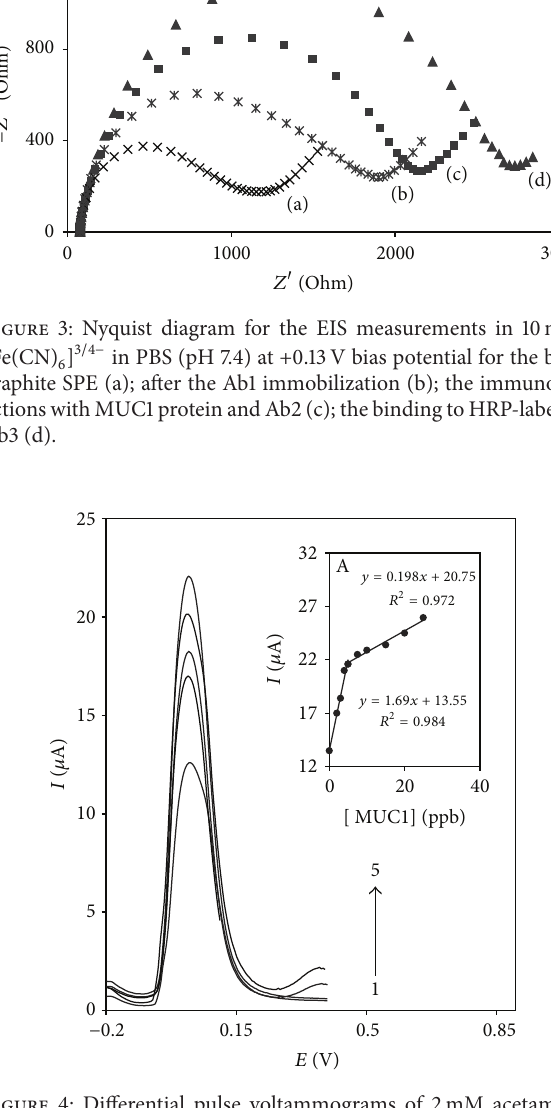
Figure 4: Differential pulse voltammograms of 2mM acetamin- ophen in 0.1M PBS (pH 7.4) containing 4mM H 2 O 2 registered with Ab1-BSA/Ag/Ab2/Ab3 modified MBs for different concentrations of MUC1 protein (1–5 correspond to 0, 2, 3, 4, and 5ppb of